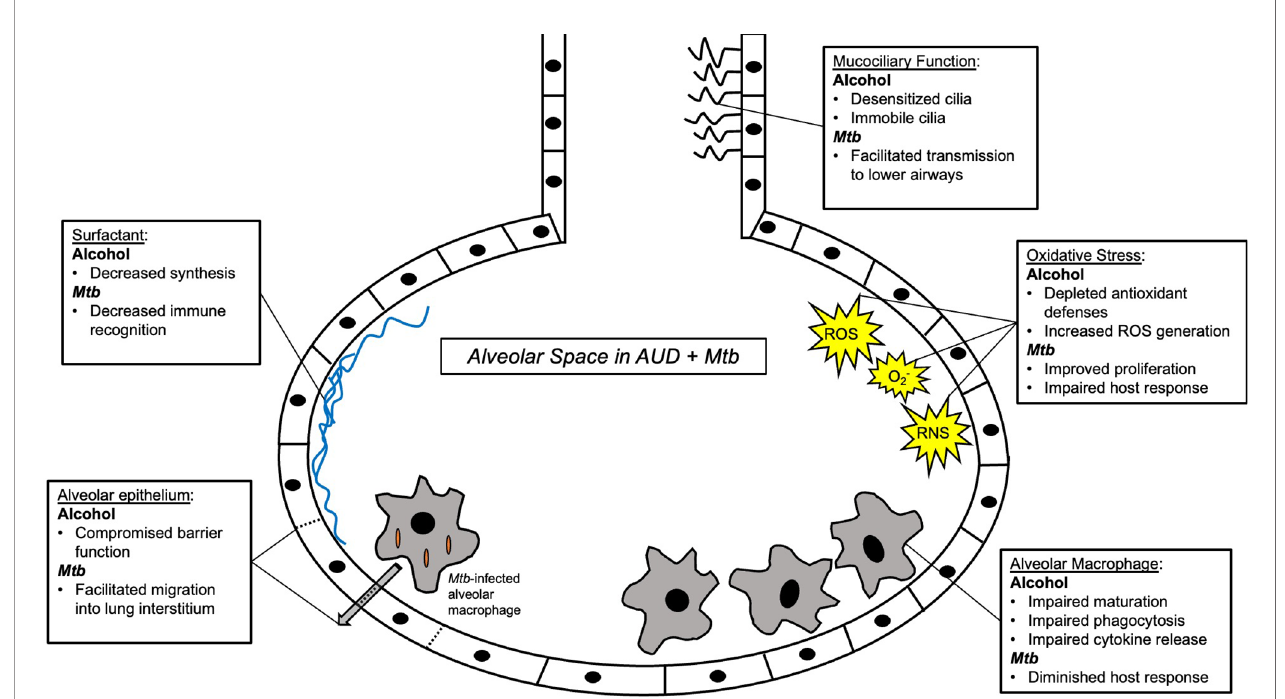
FIGURE 3 | Summary schema of the alveolar space in alcohol use disorder (AUD) and Mycobacterium tuberculosis (Mtb) infection. Multiple components of innate immunity are affected by AUD, including macrophages, surfactant, the alveolar epithelium, and the alveolar oxidative state. See main text for further